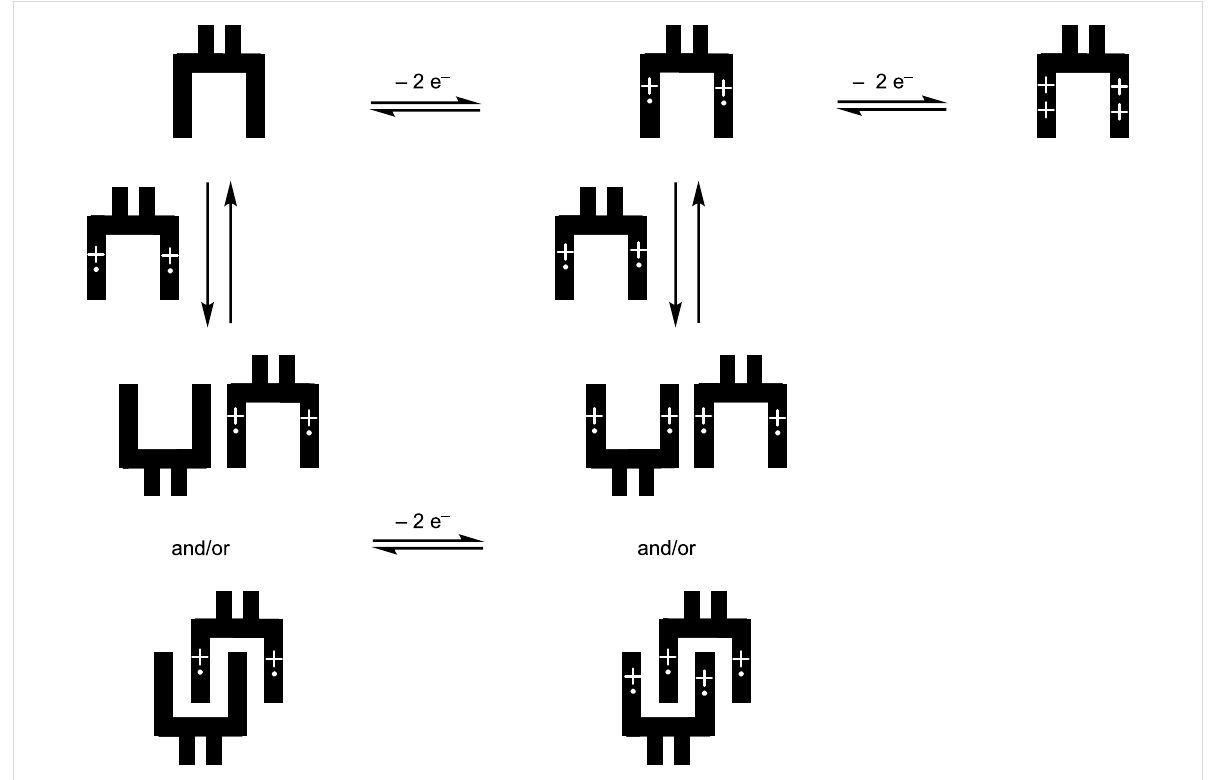
Scheme 3: Graphical representation of the stepwise oxidation of molecular clips 1 , 2 and 3 .